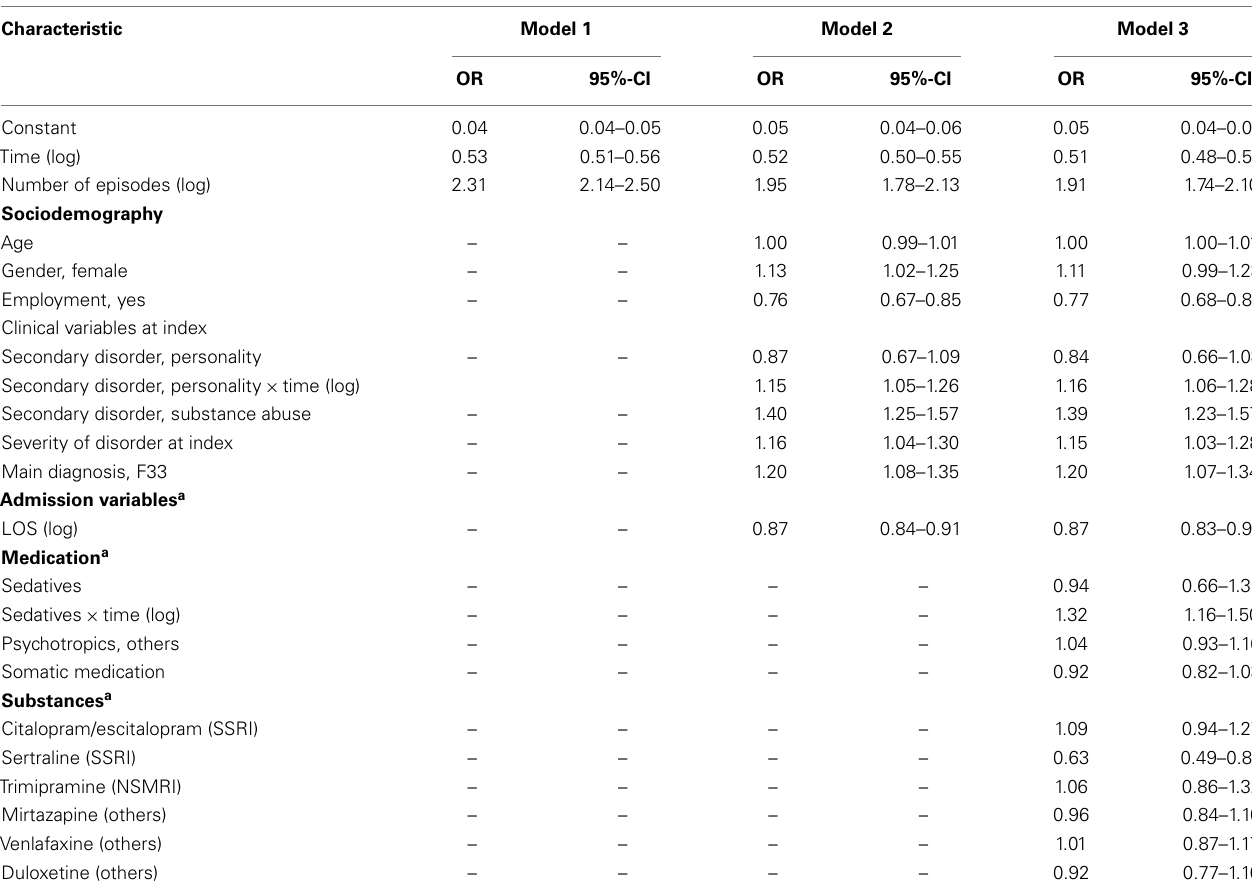
Table 2 | Discrete-time hazards model: predictors of time to readmission